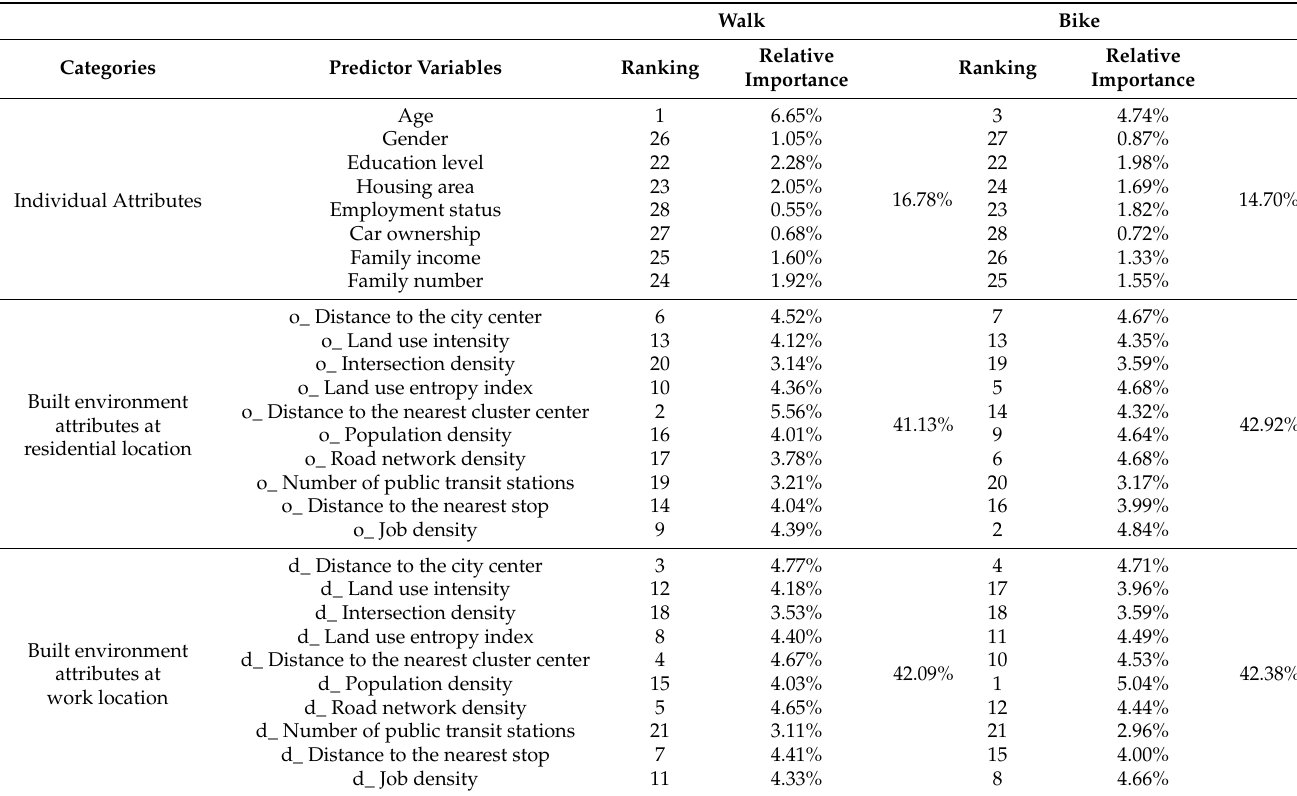
Table 6. Relative contributions of independent variables on active mode